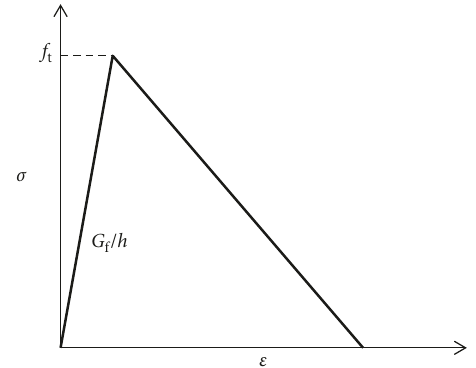
Figure 11: Tensile model with linearized